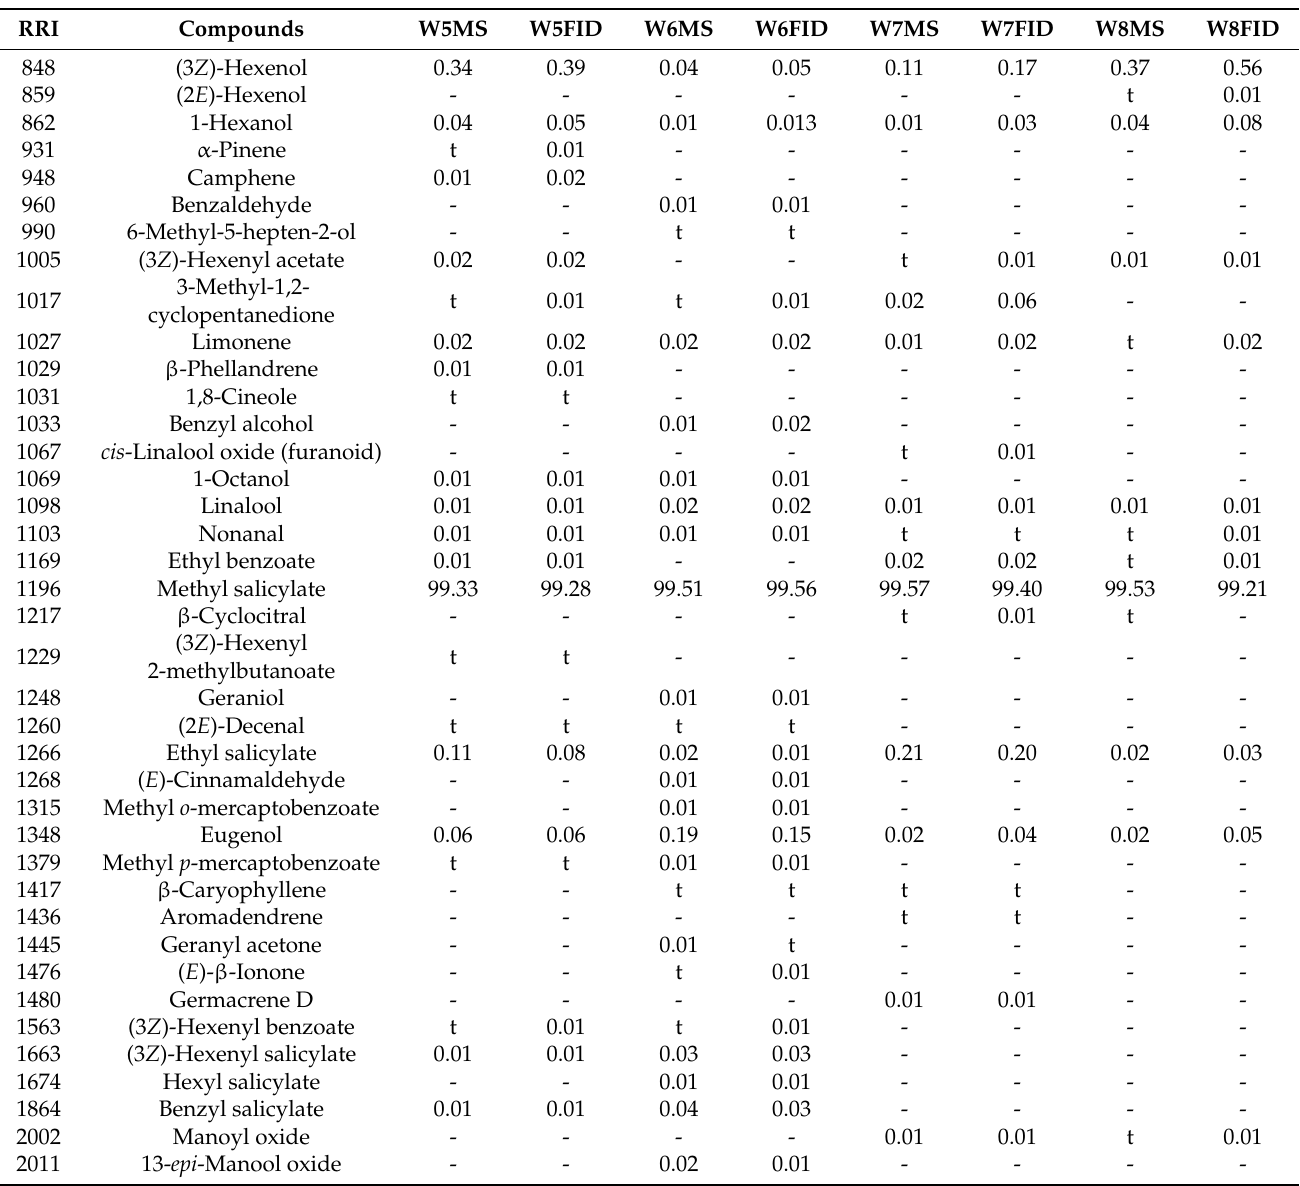
Table 4. Compositional analysis of fresh (W5), dry (W6), 18 h soaked (W7), and soaked in 5%